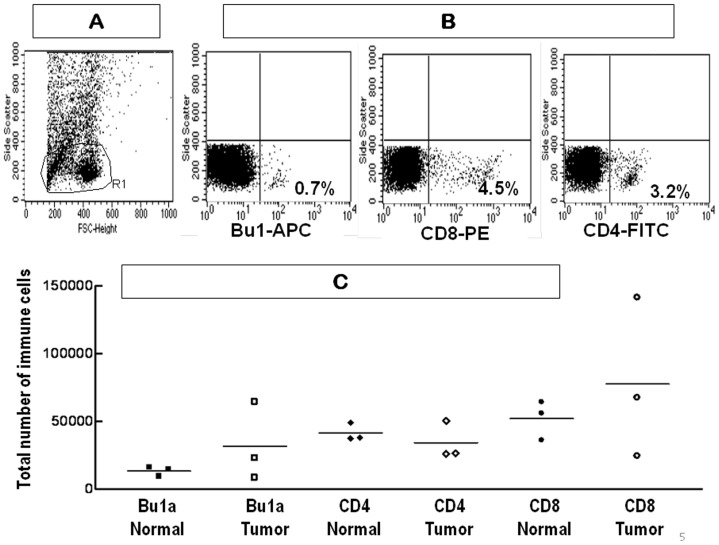
The number of ovarian CD4+, CD8+ and Bu1a+ cells estimated by flow cytometry.(A): Representative forward vs. side scatter plot for cells from a whole ovary showing the gate (R1) used for lymphocytes. (B) Cells were first gated using the gate in (A) and then stained with either Bu1a-APC, CD4-FITC or CD8-PE. The percent of labeled cells within the gate is shown in the lower right quadrant for each stain. (C) The total number of Bu1a-APC, CD4-FITC and CD8-PE labeled cells from normal and tumor hen ovaries (n = 3/group) are shown with the median indicated by the horizontal line.